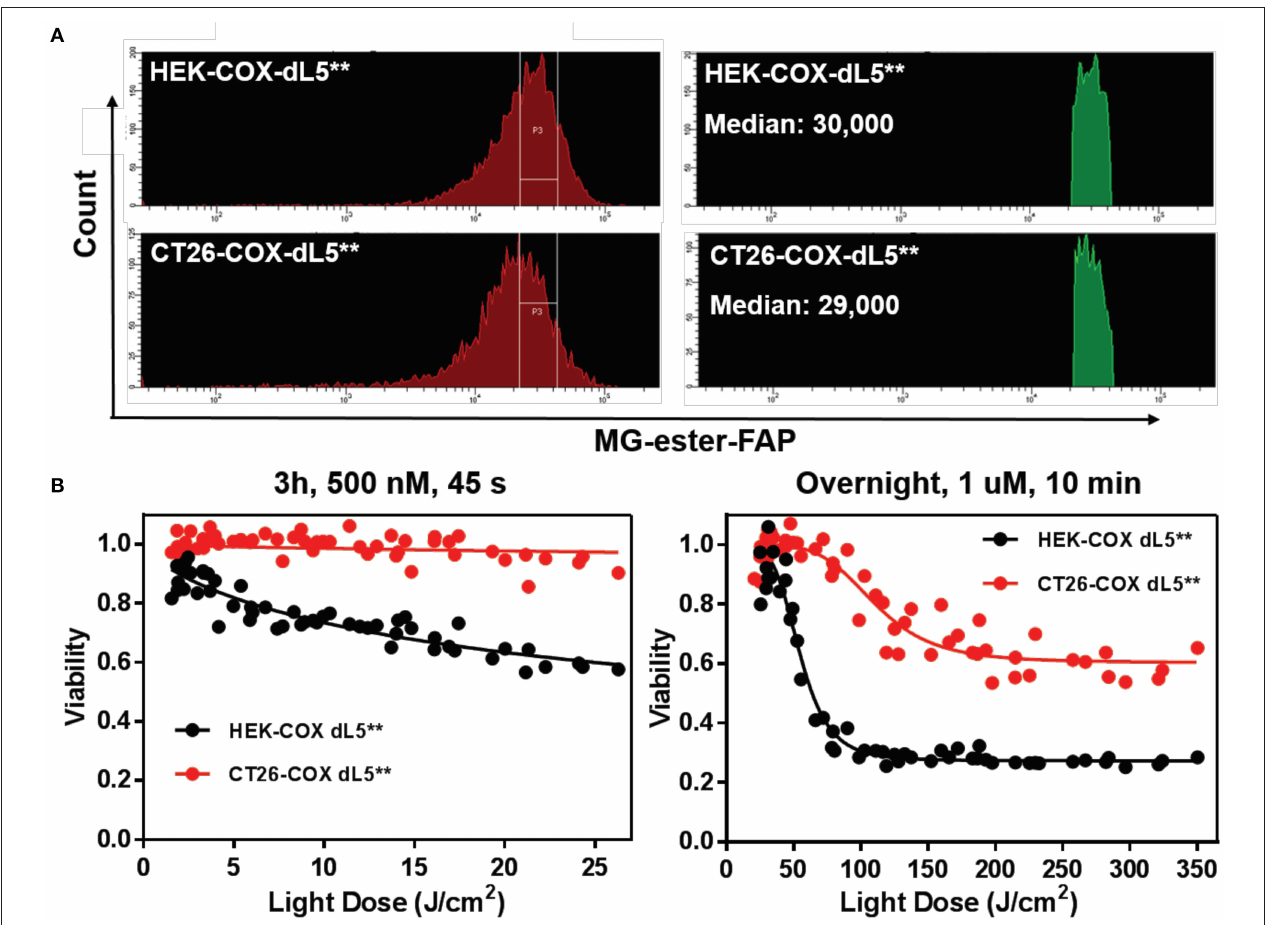
FIGURE 5 | HEK cell and CT26 cells with mitochondrially localized FAP show dramatically different sensitivity to singlet oxygen generation. (A) Populations of cells with initially similar FAP expression (MG-ester-FAP signal) were collected within the indicated gate region to narrow the fluorescence distribution, with the population falling in the gate shown as a fluorescence histogram in green on the right, with the associated population medians. (B) The phototoxic dose–response curves of collected cells reveal that CT26 cells are remarkably resistant to mitochondrially generated singlet oxygen compared to the HEK cells with similar expression